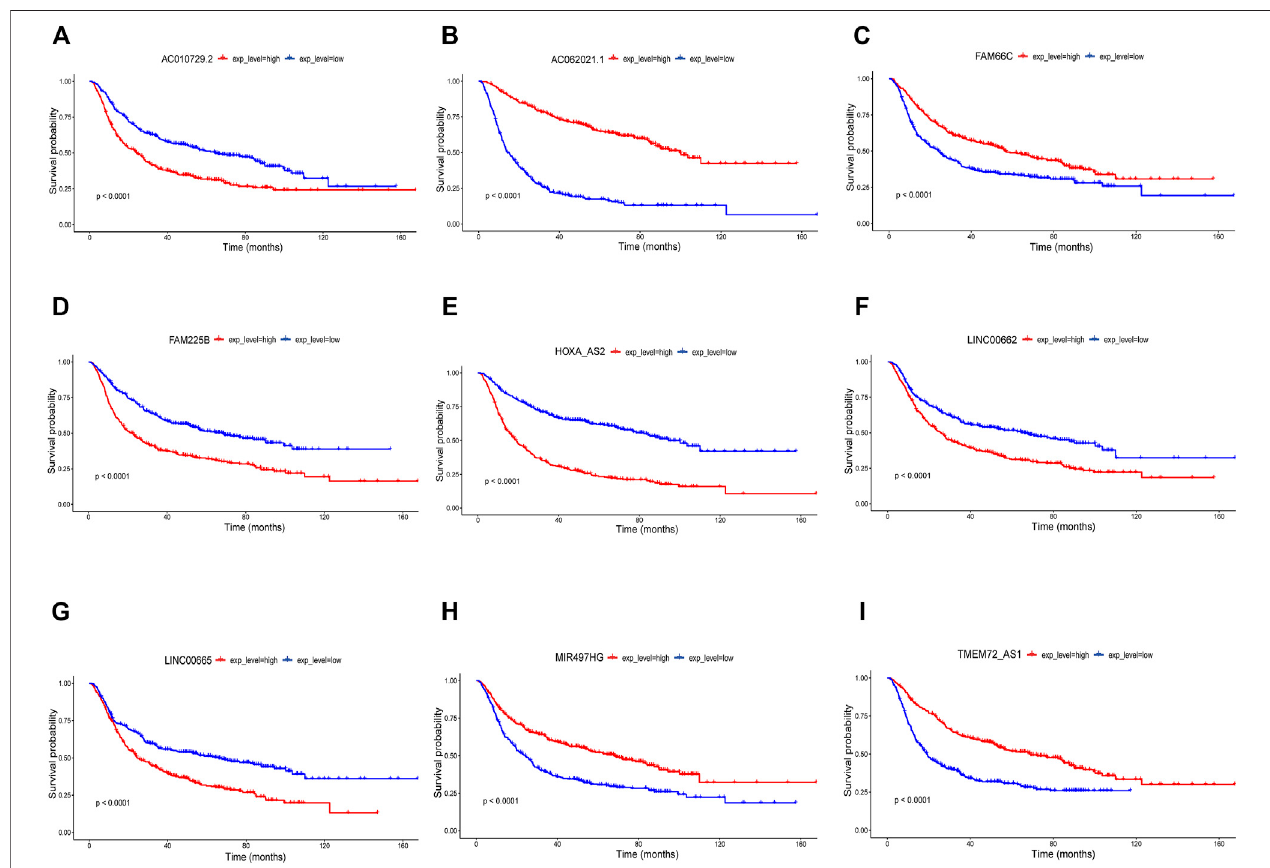
FIGURE3 | Nine biomarkers in Kaplan-Meier analysis inthe training CGGA693 cohort (A) AC010729.2, (B) AC062021.1, (C) FAM66C, (D) FAM225B, (E) HOXA- AS2, (F) LINC00662, (G) LINC00665, (H) MIR497HG and (I) TMEM72-AS1.